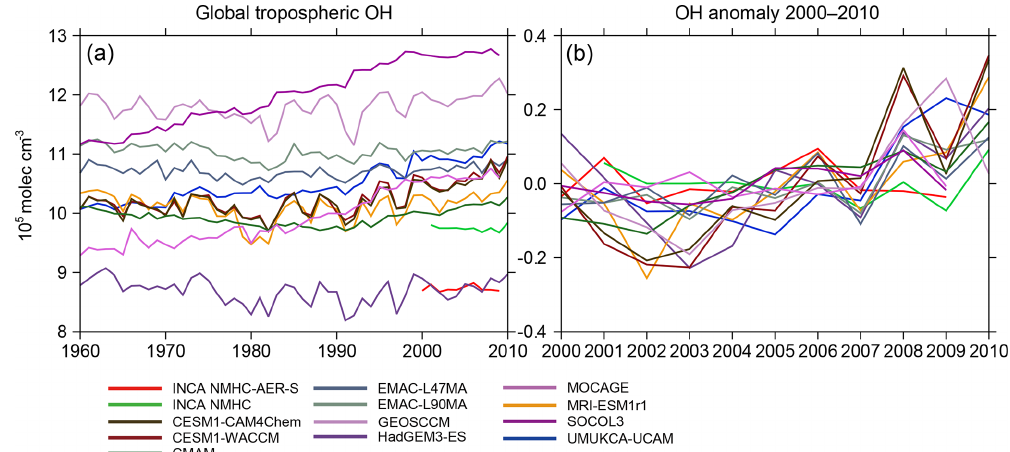
Figure 4. (a) Interannual variations of global volume-weighted tropospheric mean [OH] from CCMI and INCA model simulations from 1960 to 2010. (b) OH anomaly during 2000–2010 in reference to the mean concentration over the period 2000–2010 for each